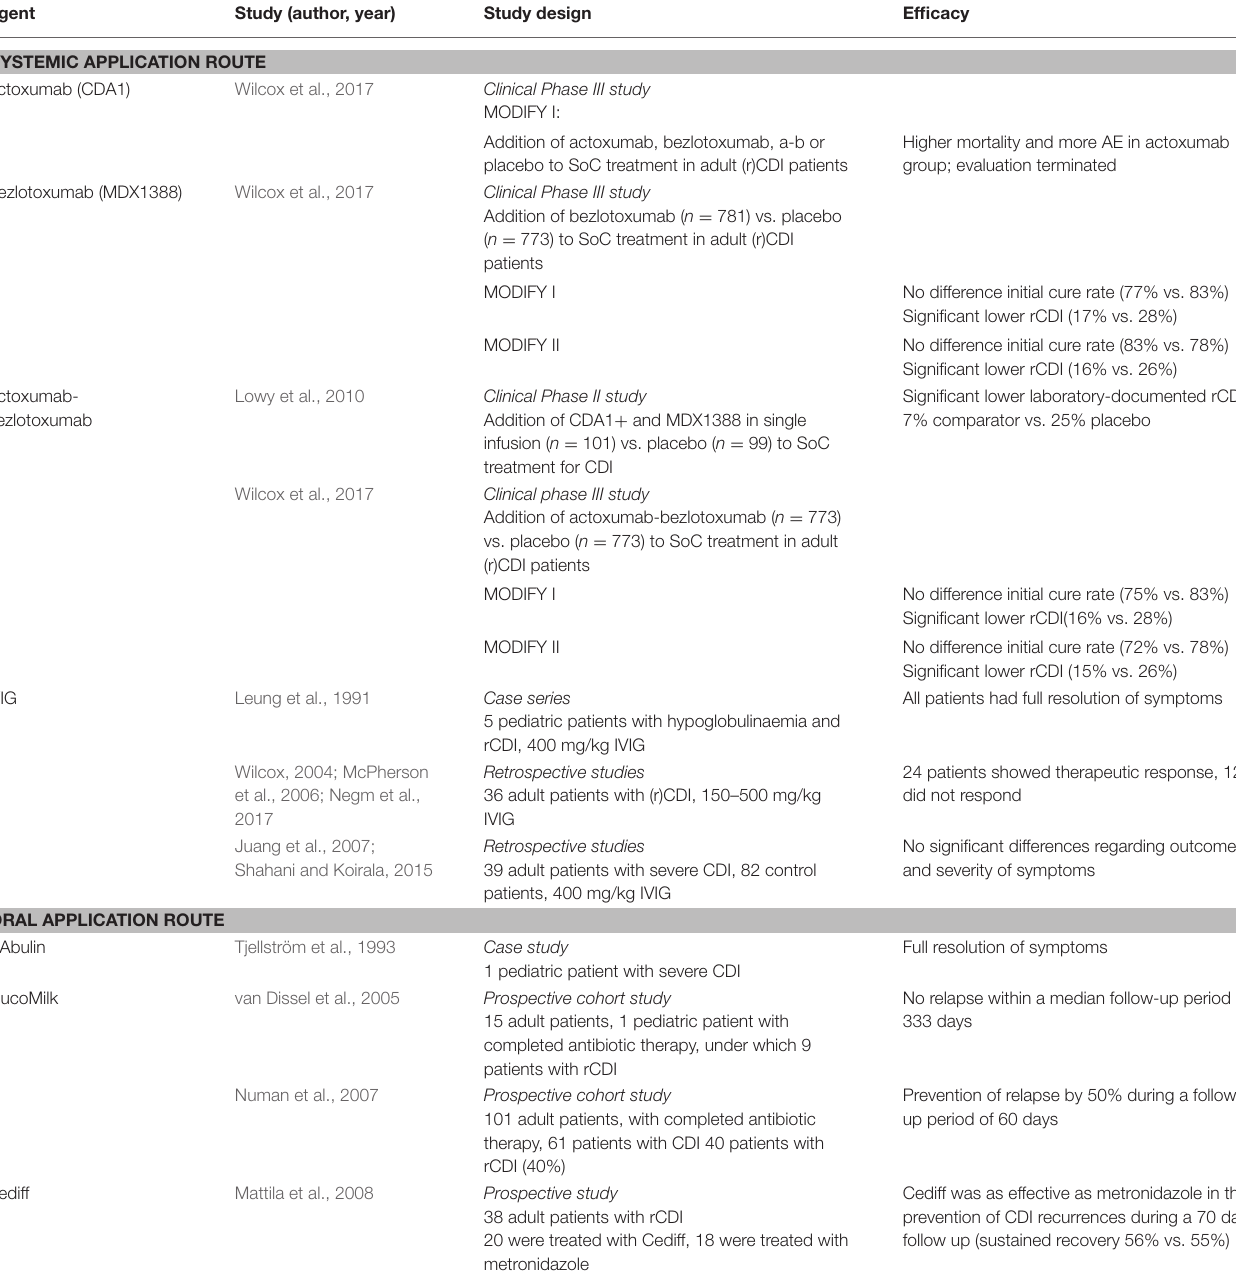
TABLE 2 | Studies evaluating antibody-mediated therapeutics in